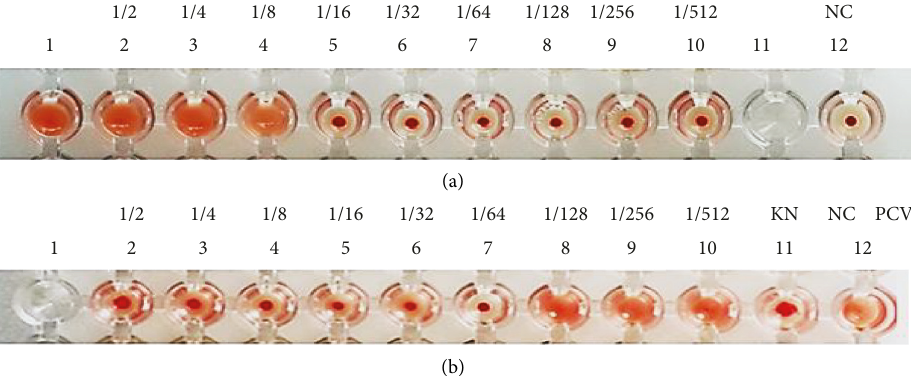
Figure 2: (a) The result of hemagglutination AMV and (b) the result of AMS antibody antihemagglutination AMS inhibited hemag- glutination AMV.